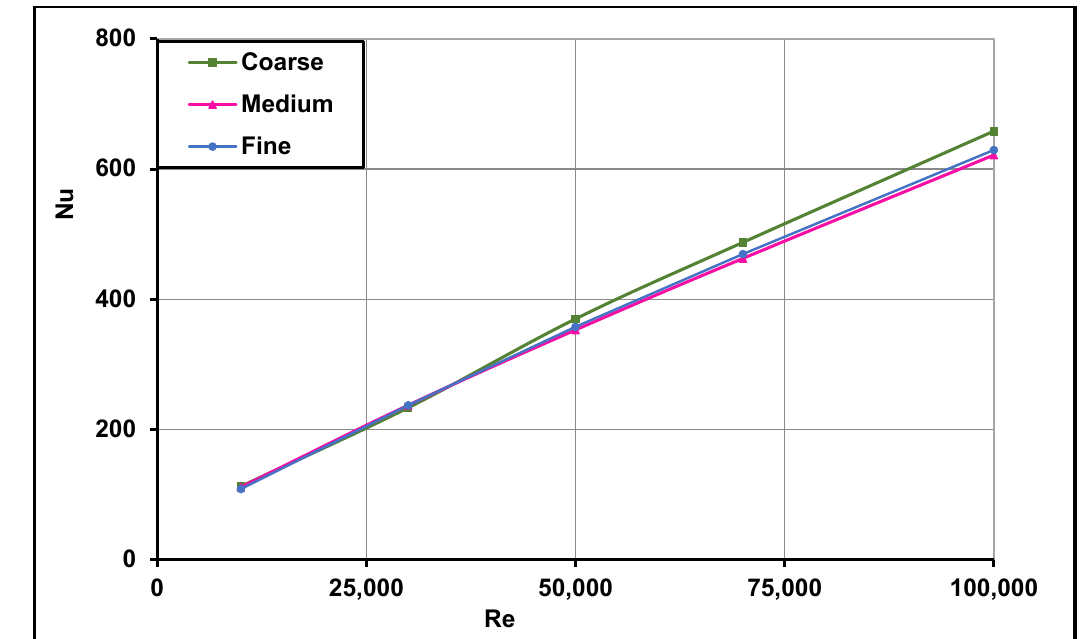
Figure 6. Mesh independence study for a typical receiver without inserts.